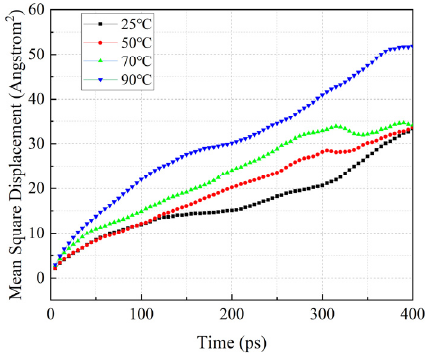
Figure 13. Variation of mean square displacement of PP at different